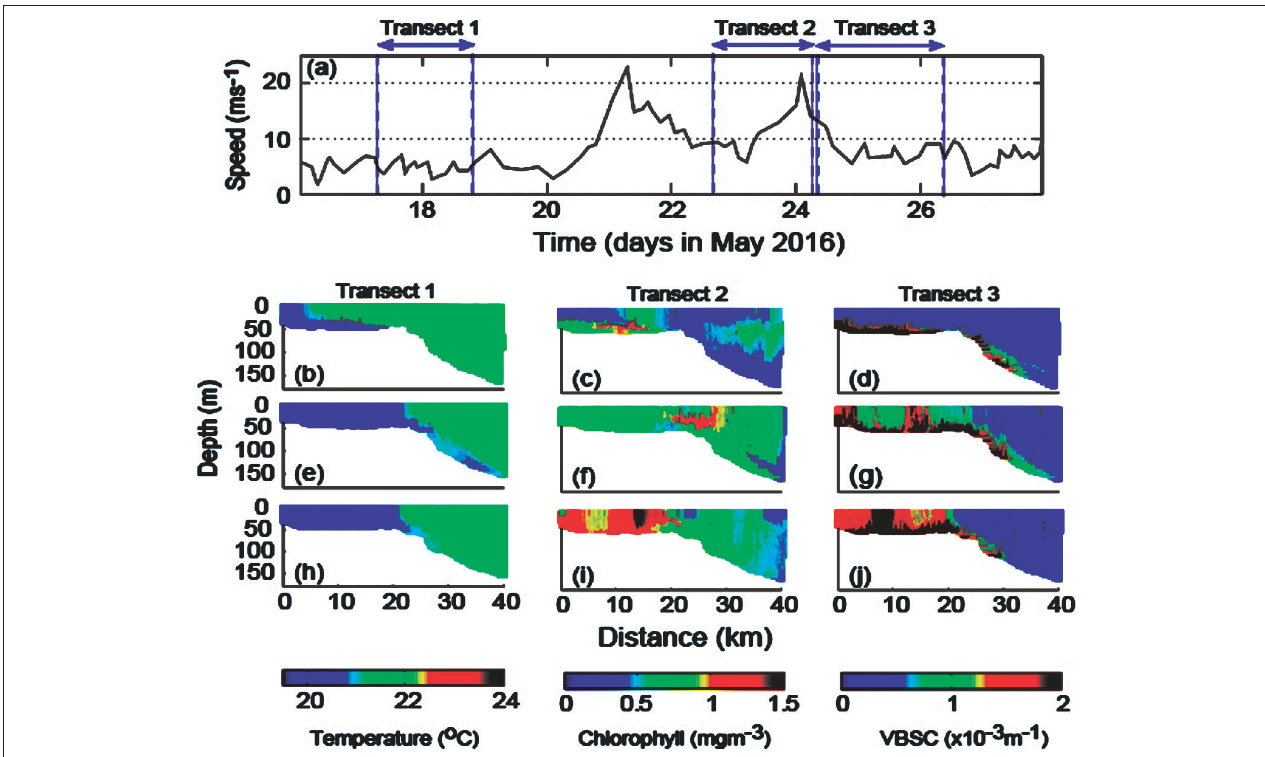
FIGURE 9 | (a) Wind speed and direction at Rottnest Island, south-west Australia. The vertical dashed lines represent timing of the ocean glider transects; Ocean glider vertical cross-sections of: (b,e,h) temperature ( ◦ C); (c,f,i) chlorophyll (mg · m − 3 ); and, (d,g,j) backscatter (x10 − 3 m − 1 ) across the Rottnest continental shelf. The time series of wind indicate calm winds (speeds ∼ 5m · s − 1 ) followed by two winter storms (speeds > 20m · s − 1 ). The wind speeds reduced to ∼ 7m · s − 1 on 23 May before increasing again to > 20m · s − 1 . There were 3 cross-shore ocean glider transects during this period. During the calm period (17–18 May 2016), a well-mixed water column with cooler ( ∼ 20 ◦ C) water was present on the inner-shelf region to 5km from the coast. Seaward of 5km, a dense shelf water cascade (DSWC, Pattiaratchi et al., 2011) was present and extended along the sea bed to the shelf break. On the inner shelf, chlorophyll concentrations and backscatter values were higher within the DSWC and low in the surface layer. The two storms vertically mixed the continental shelf resulting in a well-mixed water column, increased suspended sediment elevated chlorophyll concentrations (modified from Chen et al., in